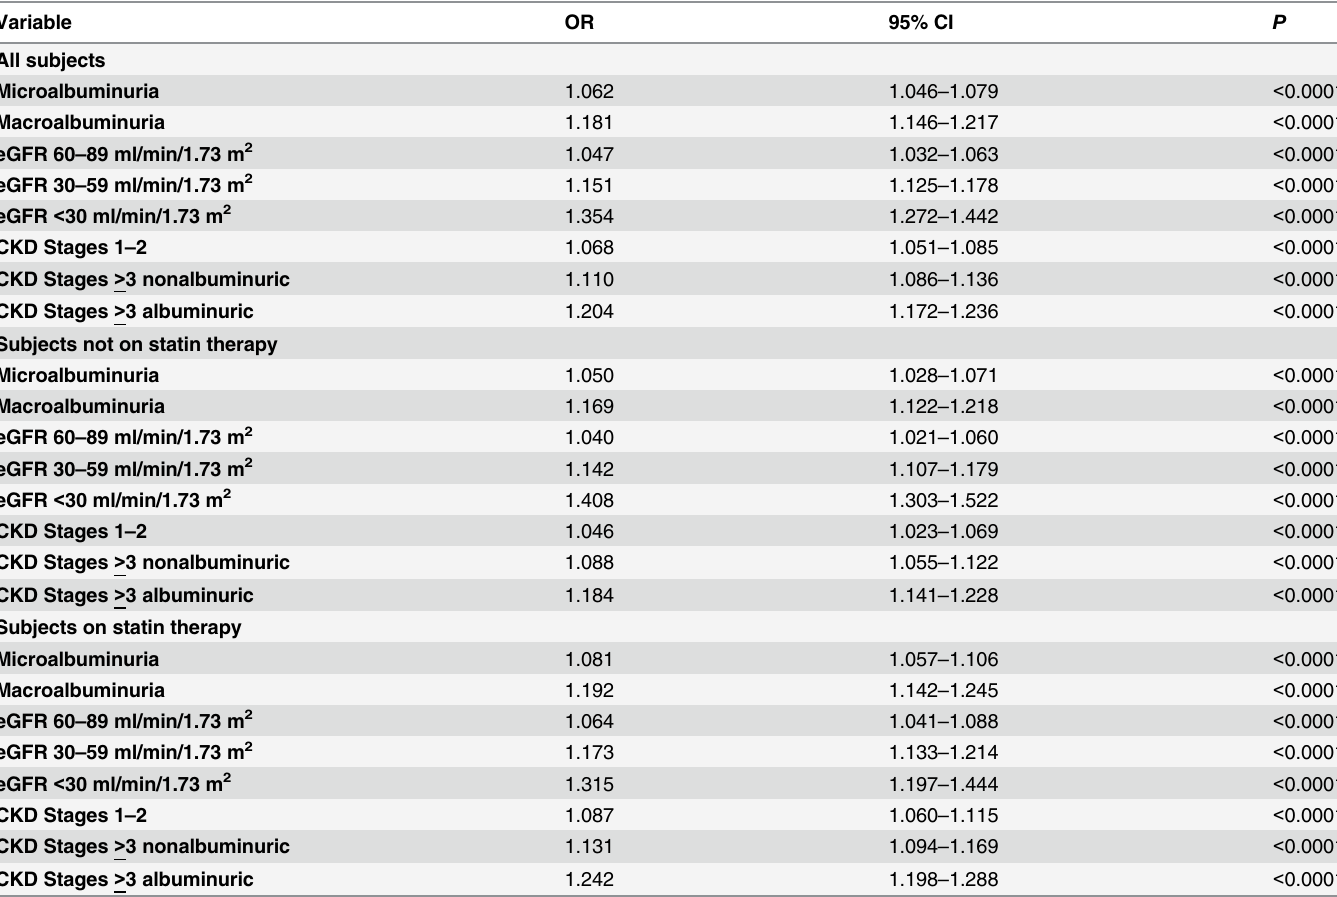
Table 5. Odds ratios corresponding to a difference of one decile in triglycerides levels for measures of CKD in all subjects and in those without and with statin treatment. * Variable